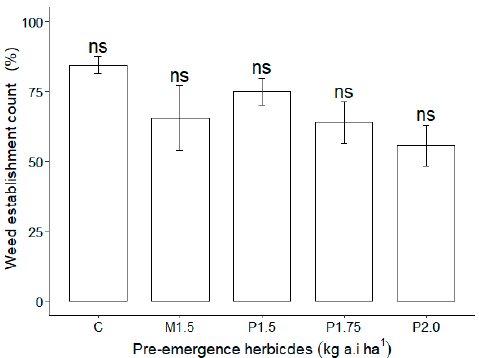
Figure 2. Effect of pendimethalin rates (P1.5, P1.75, P2.0 kg a.i. ha − 1 ), treated control with S - metolachlor at 1.5 kg a.i. ha − 1 (M1.5) and untreated control (C) on barnyard grass. ‘ns’ means not significant; error bars represent the standard error.